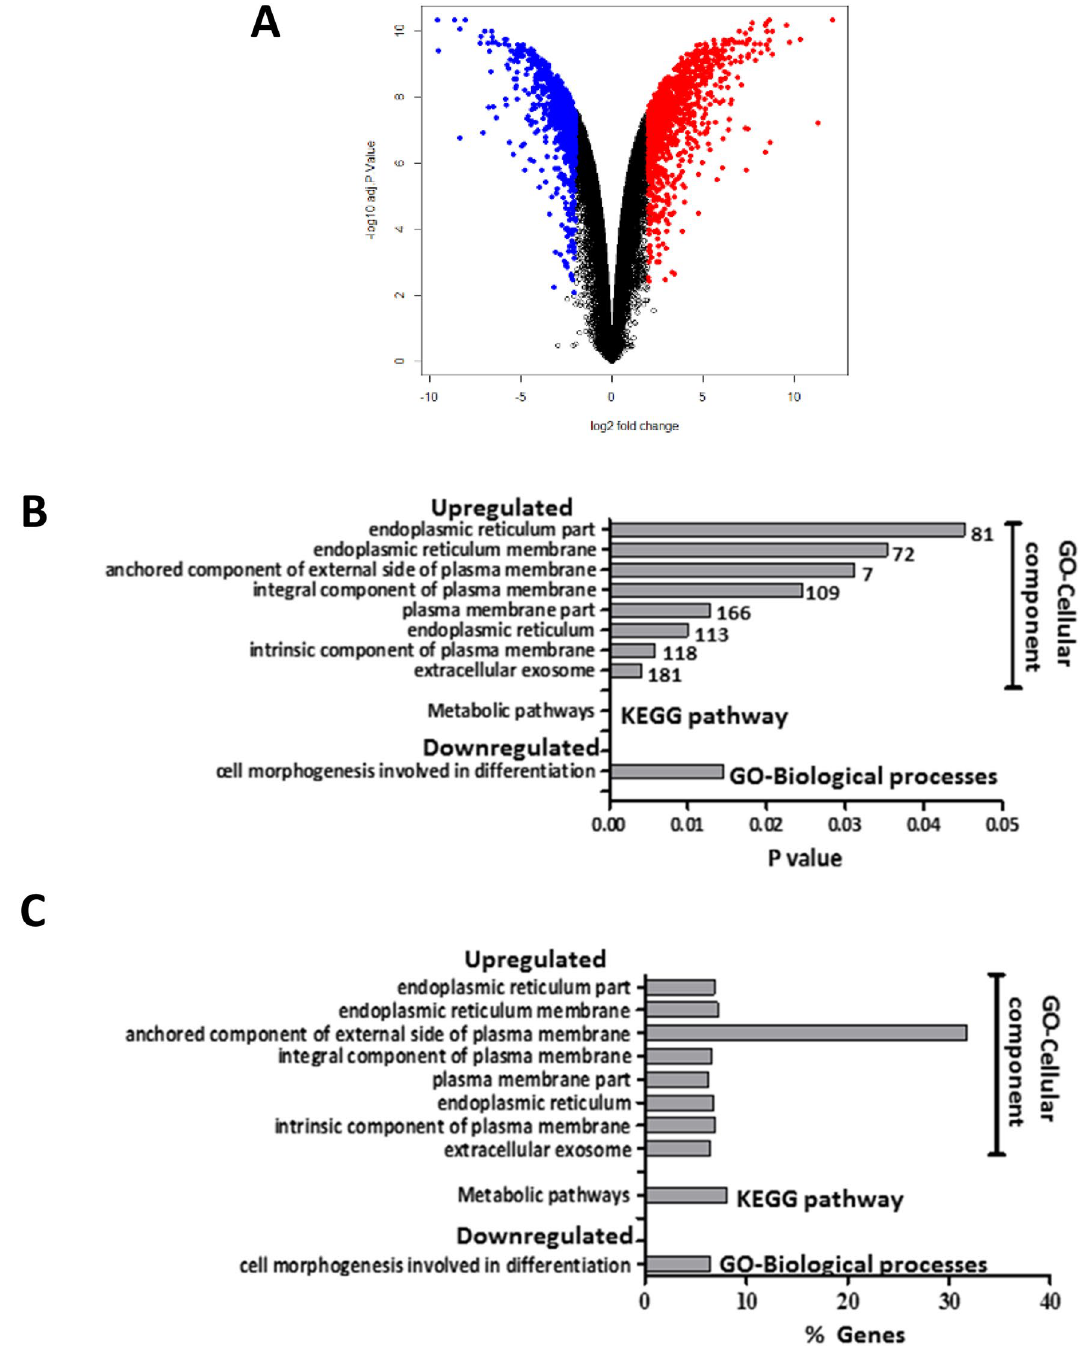
Figure 5. Volcano-plot of differentially expressed genes (DEGs) between DHSF-BR16 and MCF-7 cells. ( A ) DEGs were retrieved by combining linear models with empirical Bayes analysis. Modified t test raw p values were adjusted for multiple testing by using Benjamini–Hochberg procedure. Red dots and blue dots represent upregulated and downregulated DEGs, respectively. Black dots, no differential expression. Based on logFC > 2 and p -adj < 0.01, a total of 1214 upregulated and 857 downregulated genes were identified. The magnitude of fold changes (log2 scale) was within − 9.6 to + 12.13. ( B ) Number of genes included in the significantly upregulated or downregulated pathways, based on the GO and KEGG enrichment analysis. Grey bars indicate the magnitude of statistical significance. Numbers at the end of grey bars represent the number of genes for each pathway. ( C ) Percentages of genes included in the significantly upregulated or downregulated enriched pathways on the total of genes included in each